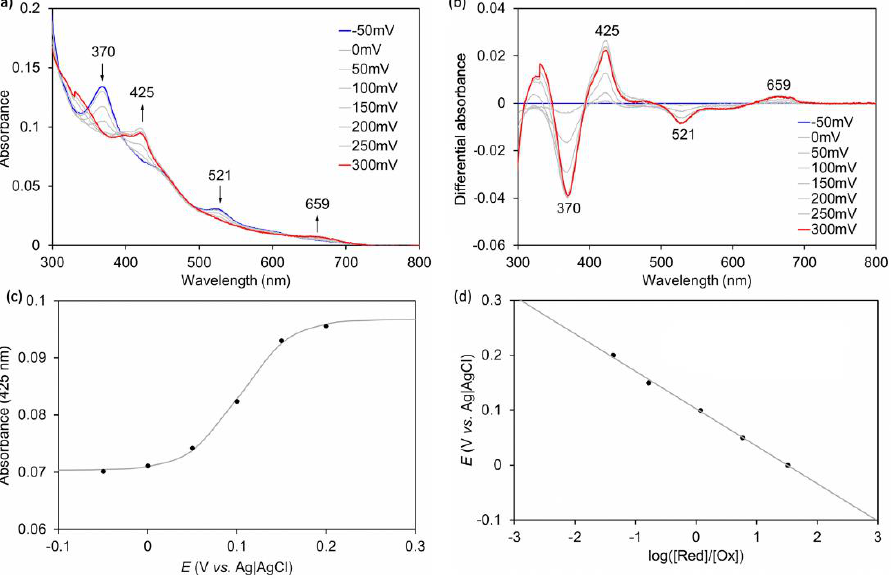
Figure 8. ( a ) UV-vis spectral changes of rMb(CoCor) during applied voltage changing from −50 mV to 300 mV (vs. Ag|AgCl). ( b ) Differential spectra of ( a ). ( c ) Absorption changes at 425 nm in ( a ) against the potentials. ( d ) Nernst plots obtained by spectroelectrochemical measurement of rMb(CoCor). [rMb(CoCor)] = 150 μM, [hydroquinone] = 1.5 mM in 100 mM potassium phosphate buffer (pH 7.0), 25 °C.